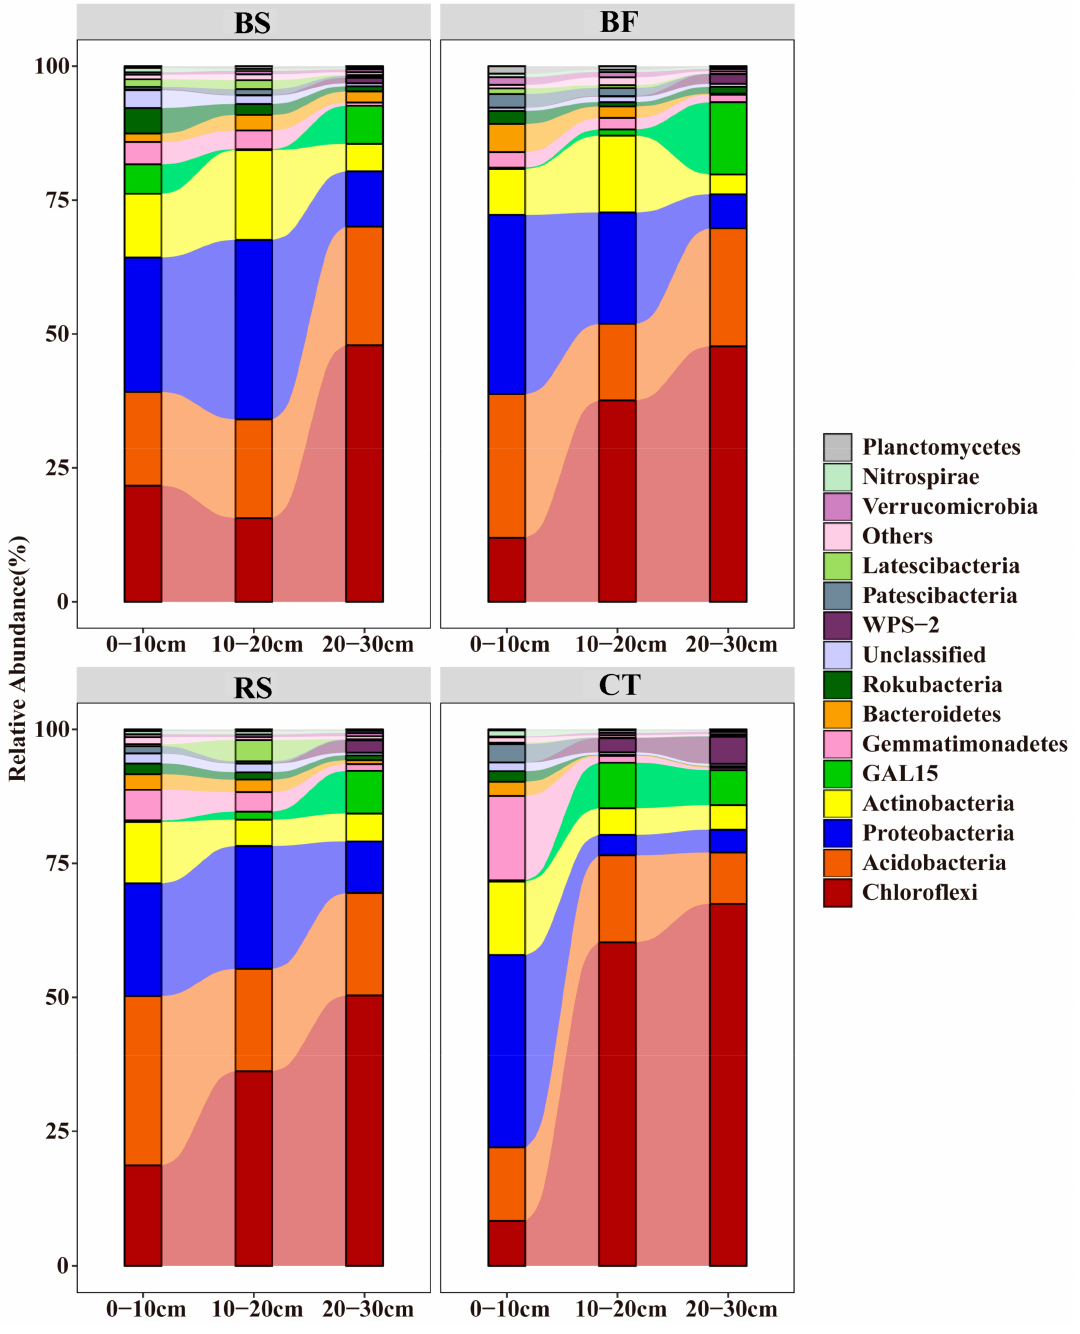
Figure 4. Phylum-level taxonomic composition of the bacterial community under different soil and water conservation measures. Note: the parts with an average abundance of less than 1% were merged and indicated by others in the